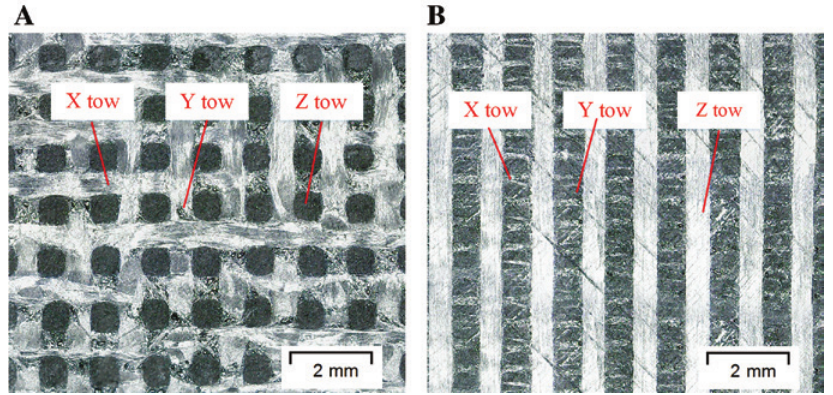
Figure 1: Micro-graphs of C/C 3D eight-harness satin weave.